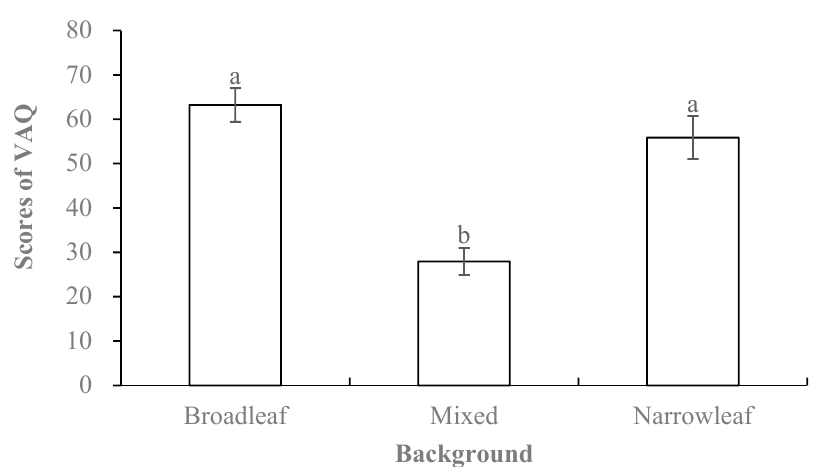
Figure 4. Visual aesthetic quality (VAQ) of three background settings using broadleaf Sophora japonica , narrowleaf Juniperus chinensis , or mixed, using both.